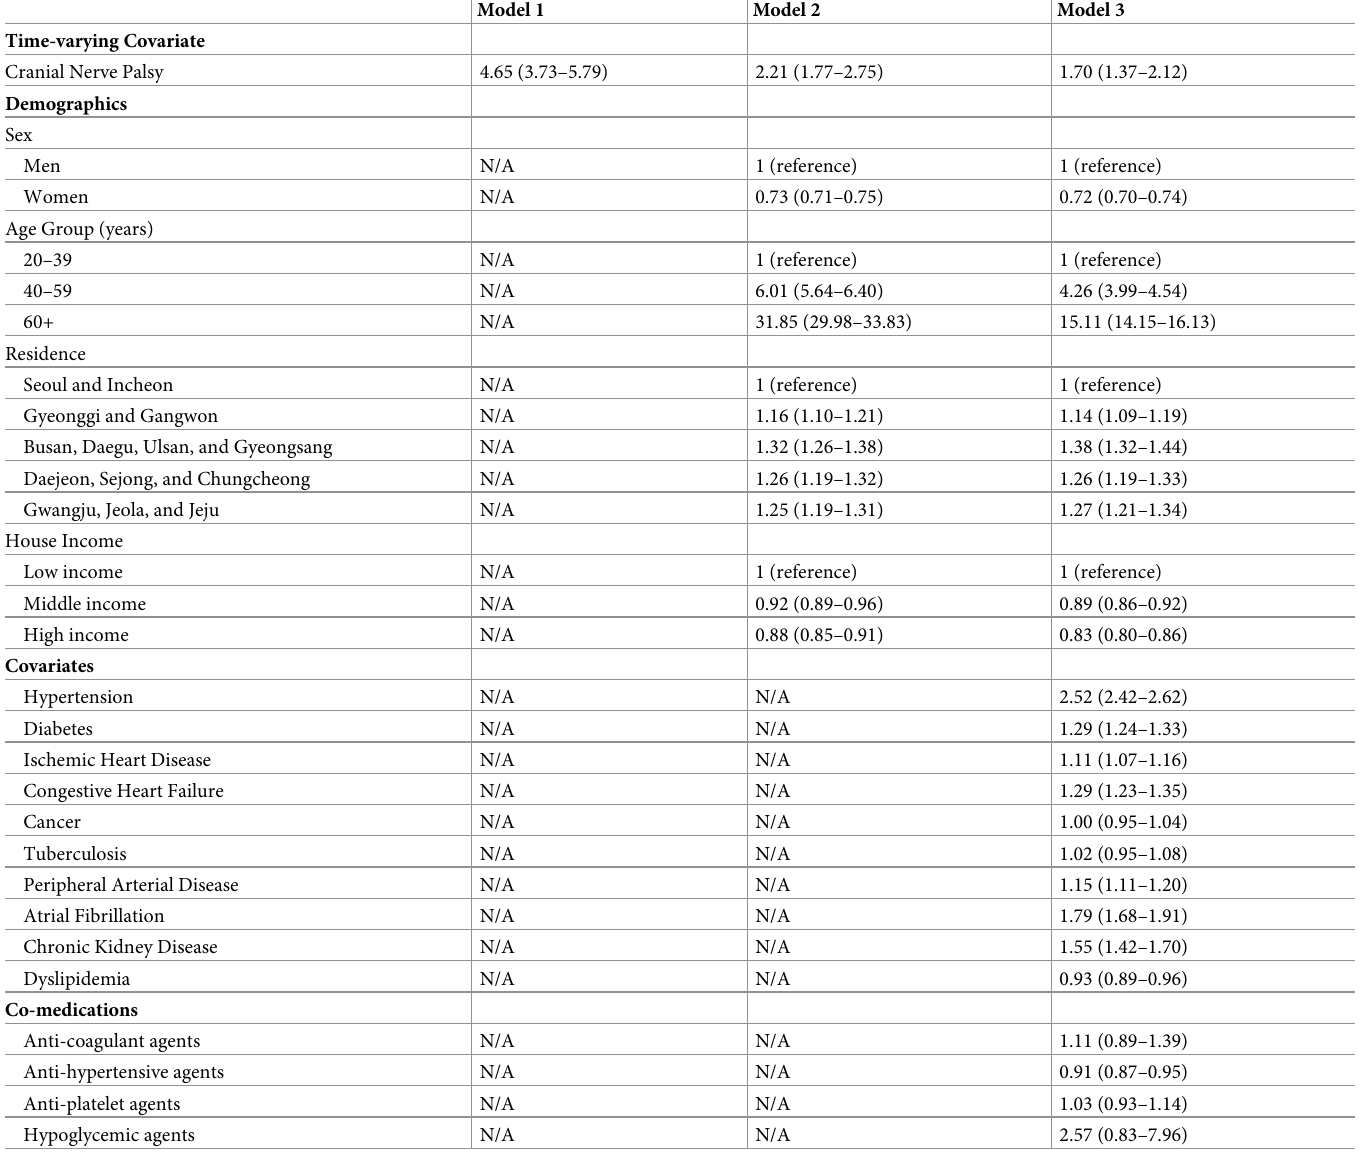
Table 2. Results of time-varying cox regression models for stroke in the eligible